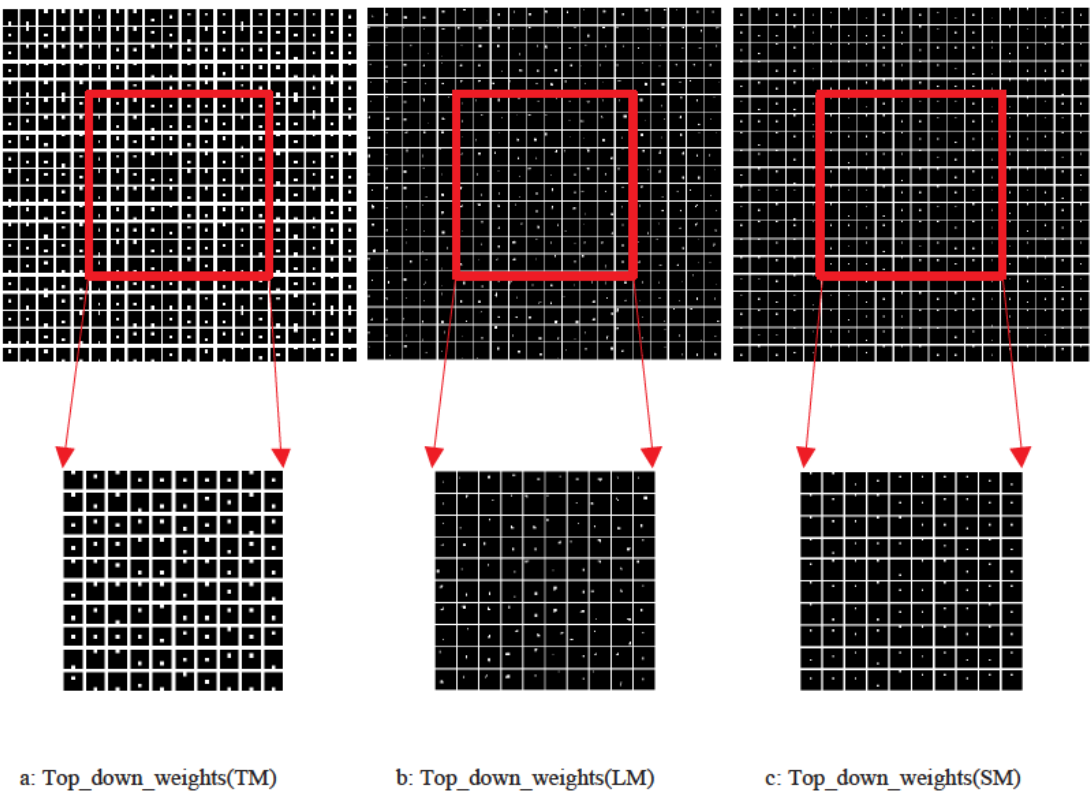
Figure 5: Visualization of the Weight Value from Z Layer to Y